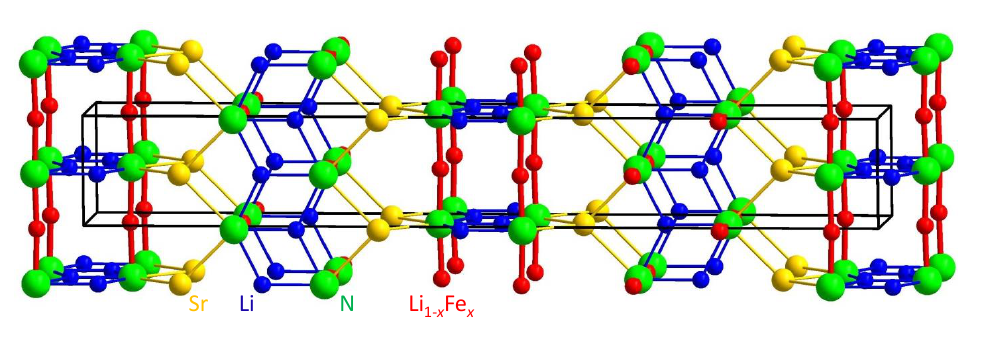
Figure 1. Crystal structure of Li 2 Sr[(Li 1 − x Fe x )N] 2 , the unit cell is indicated by the black lines (space group I 4 1 / amd ). Fe is substituted in linear, two-fold coordination between